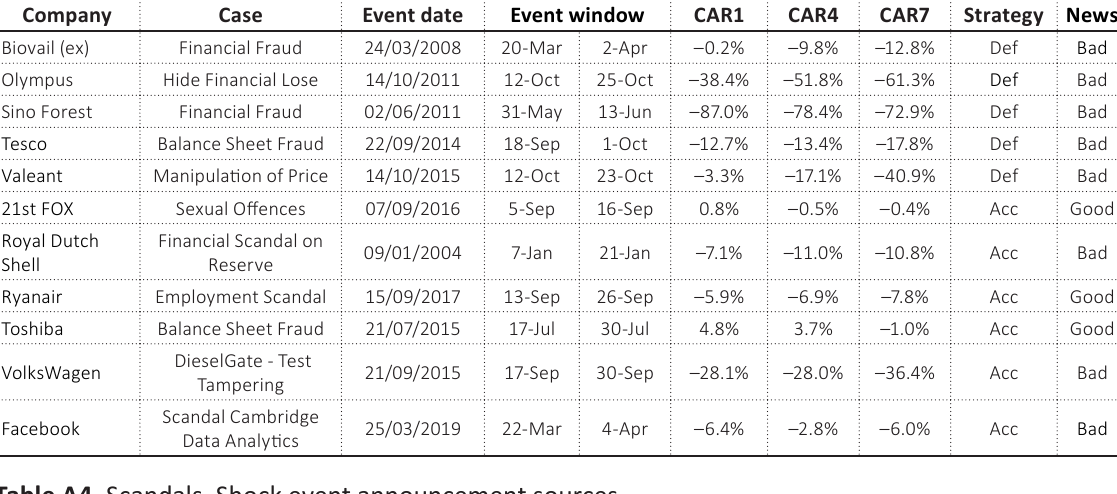
Table A4. Scandals. Shock event announcement sources